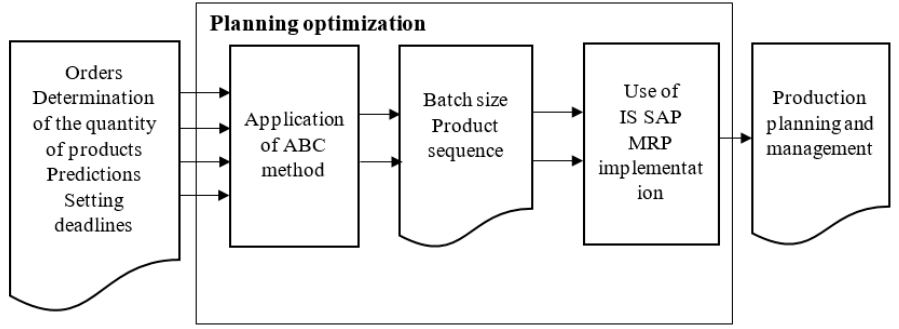
Figure 1. Application of methods for inventory-planning optimization .